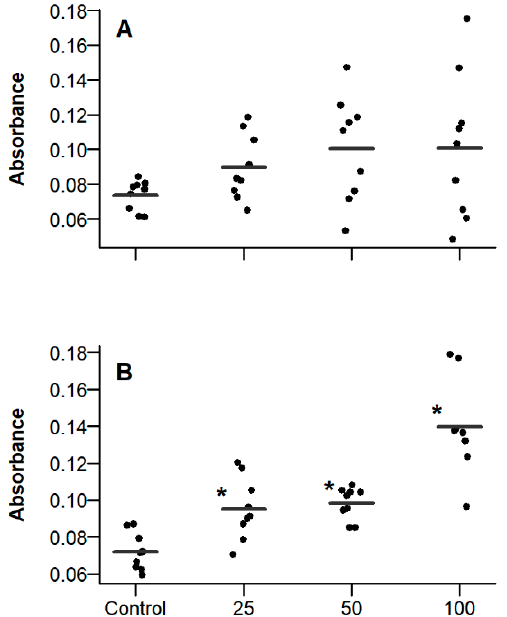
Figure 4 . Effect of phosphatidylethanolamine (PE) on apoptosis of normal human lung fibroblasts. Figure 4. Effect of phosphatidylethanolamine (PE) on apoptosis of normal human lung